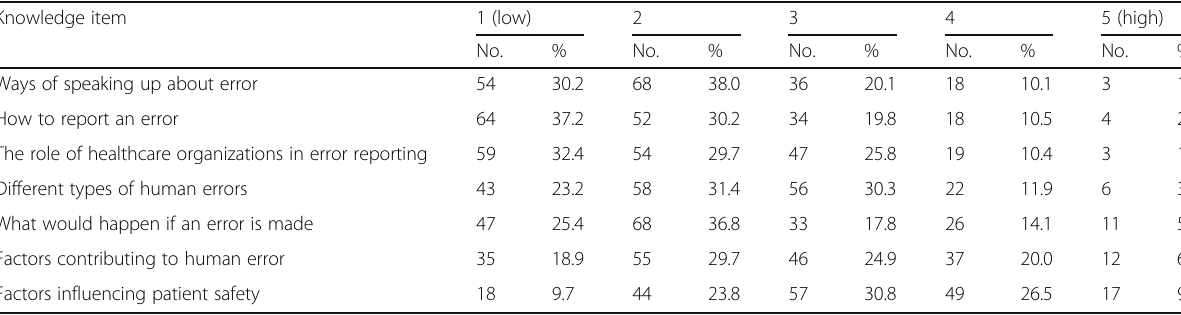
Table 2 Knowledge of participated physicians about errors and safety Knowledge